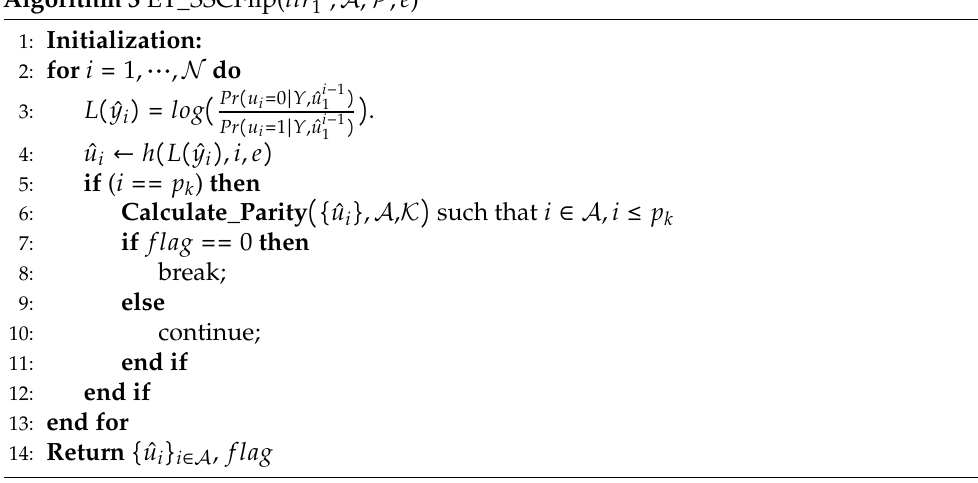
Algorithm 3 ET_SSCFlip( llr N